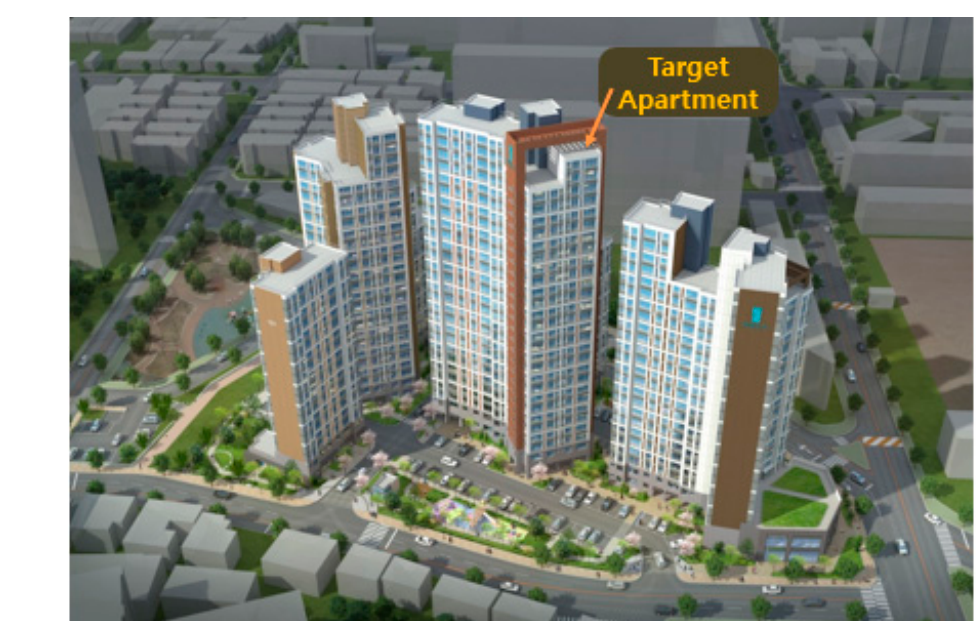
Figure 3. The perspective view of the target apartment and total block. The floor height is 28 stories, which is the highest plan in the complex. Figure 4 shows the unit floor plan of the target apartment.